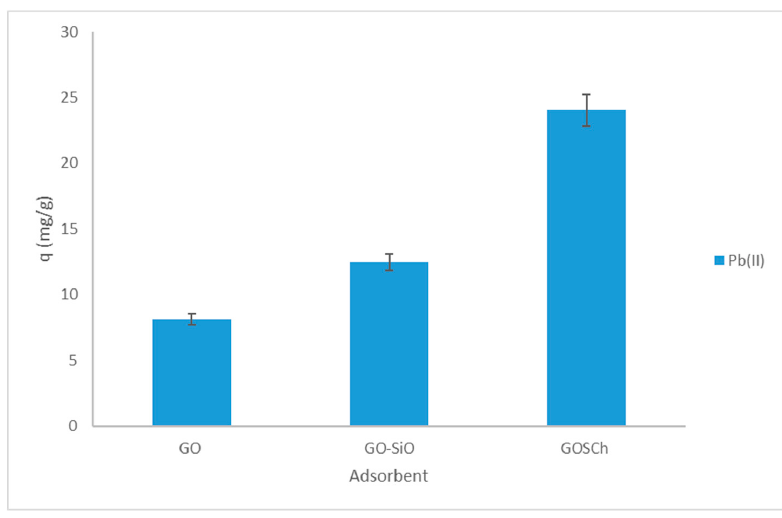
Figure 12. Comparison Adsorption Capacity of GOSCh, GO-SiO and GO.